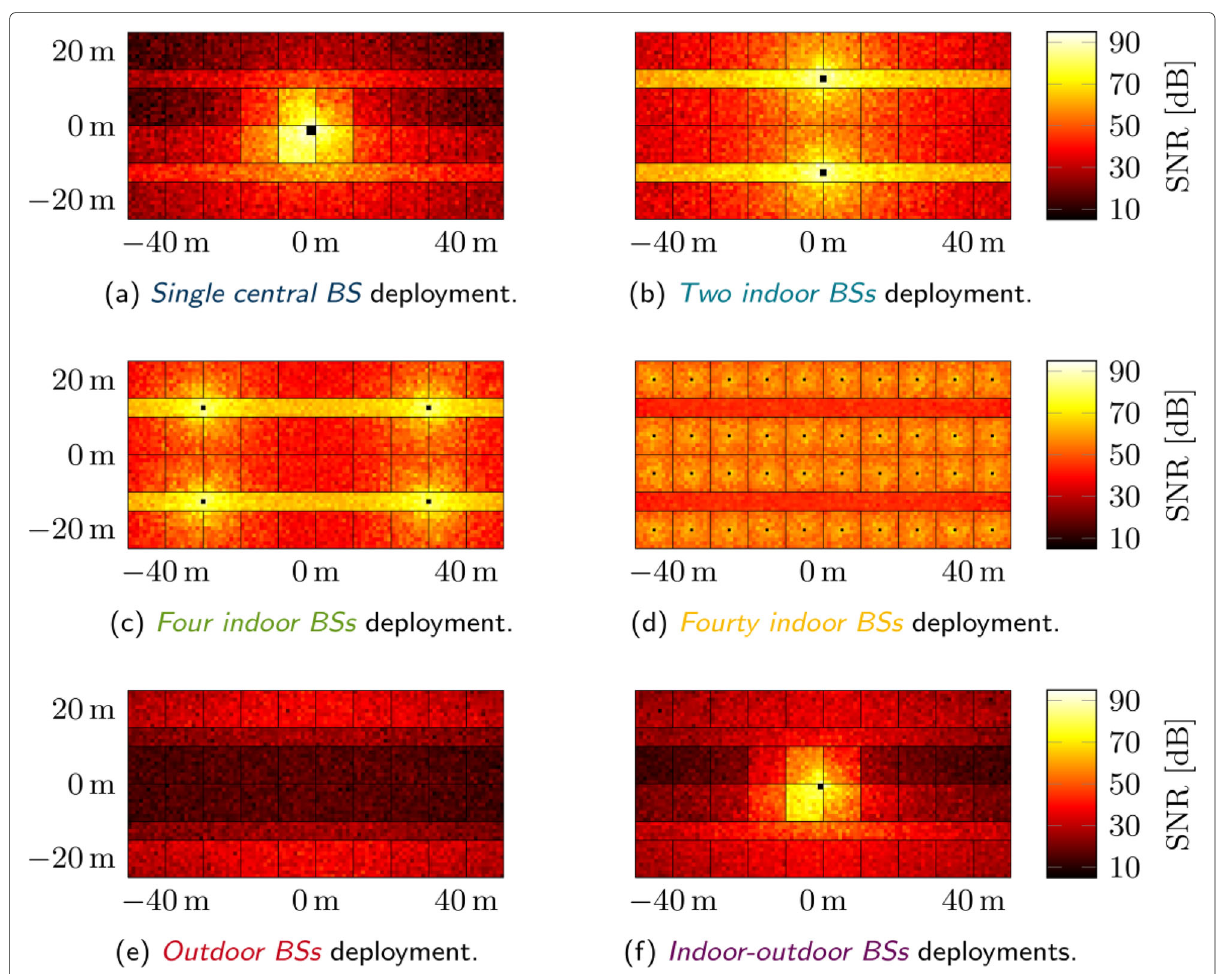
Fig. 4 Average SNR maps. Average SNR achieved at a single served UE for different positions with 48 transmit antennas (with 40 transmit antennas for the fourtyindoorBSs deployment). a Single central BS deployment. b Two indoor BSs deployment. c Four indoor BSs deployment. d Fourty indoor BSs deployment. e Outdoor BSs deployment. f Indoor-outdoor BSs